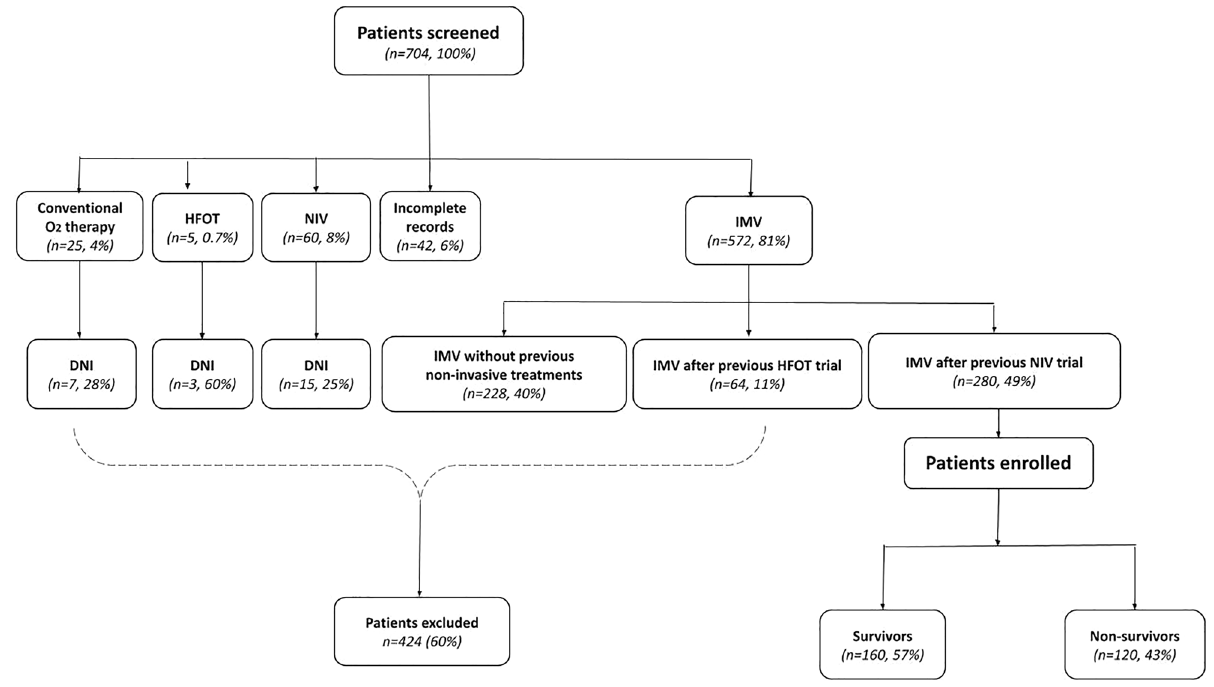
Figure 1. Flow chart of enrolled patients. HFOT: high flow oxygen therapy; NIV: non-invasive ventilation; IMV: invasive mechanical ventilation; DNI: ‘do not